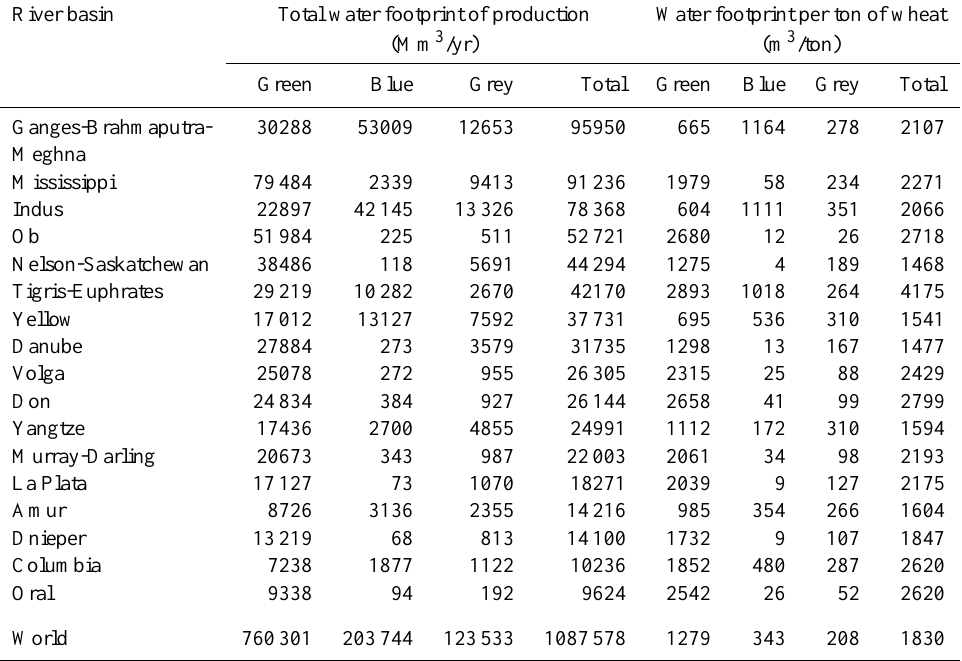
Table 2. The water footprint of wheat production for some selected river basins (1996–2005).